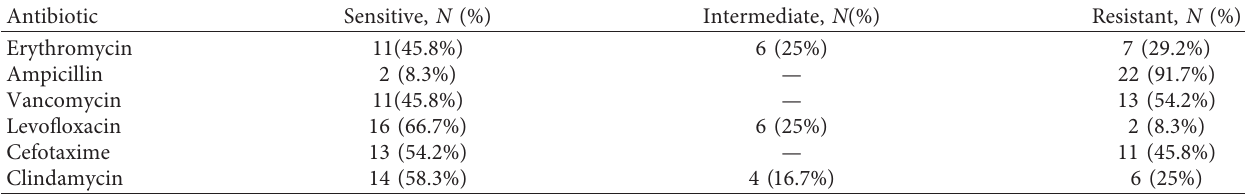
Table 4: Antibiotic susceptibilities of 24 GBS isolates from colonized pregnant women.